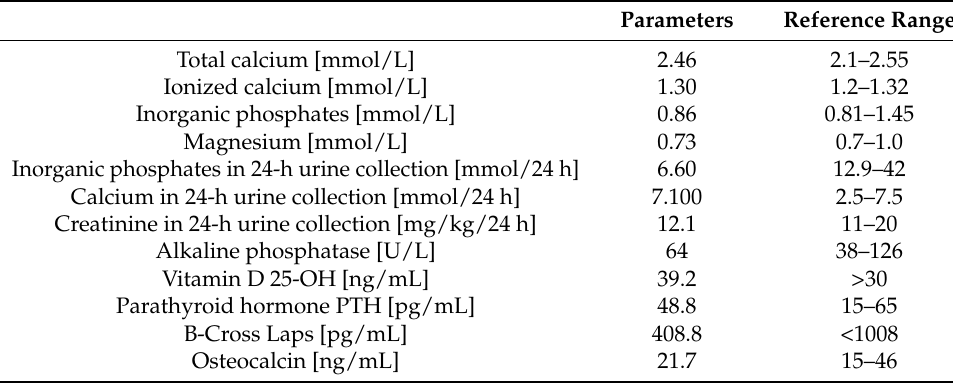
Table 1. Laboratory tests during hospitalization.